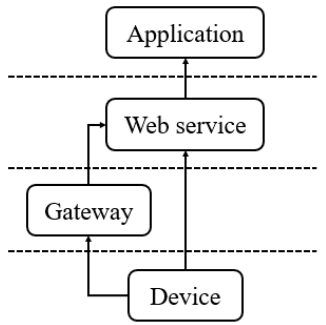
Figure 1. Architecture of Internet of Things.